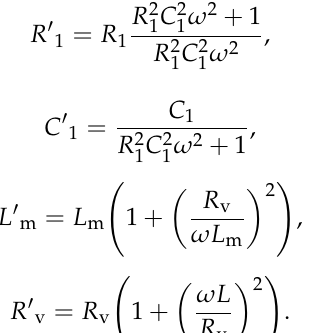
of Figure A4 are: R (cid:48) components of Figure A4 are: (cid:1844) (cid:2869)(cid:4593) = 824 k  , (cid:1829) (cid:2869)(cid:4593) = 49 fF , (cid:1844) (cid:2932)(cid:4593) = 12.8 k  , (cid:1838) (cid:2923)(cid:4593) = 27 nH .